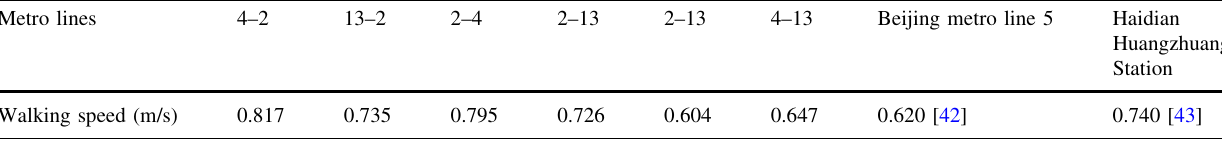
Table 6 Passenger walking speed in transfer channel in peak hours